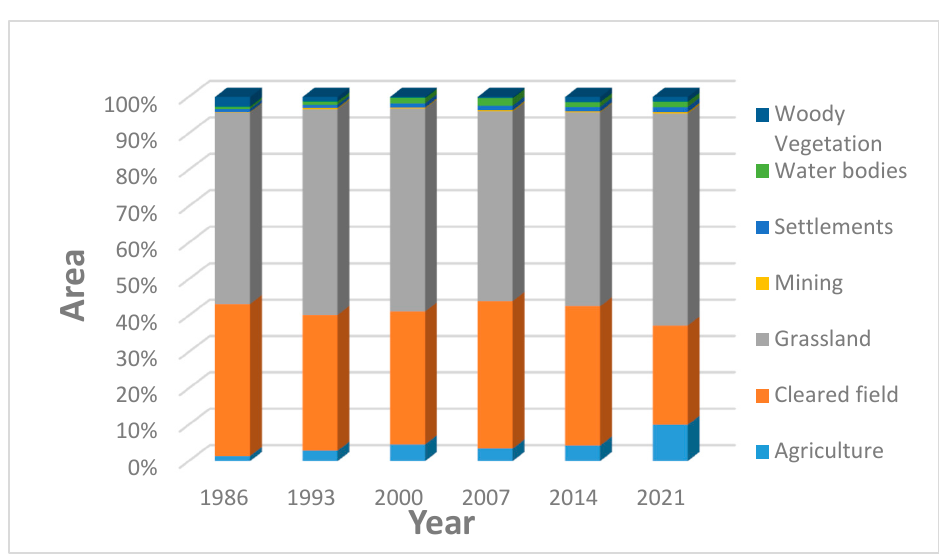
Figure 6. Land use land cover (LULC) change for 1986, 1993, 2000, 2007, 2014 and 2021 in the Vaal Dam Catchment.